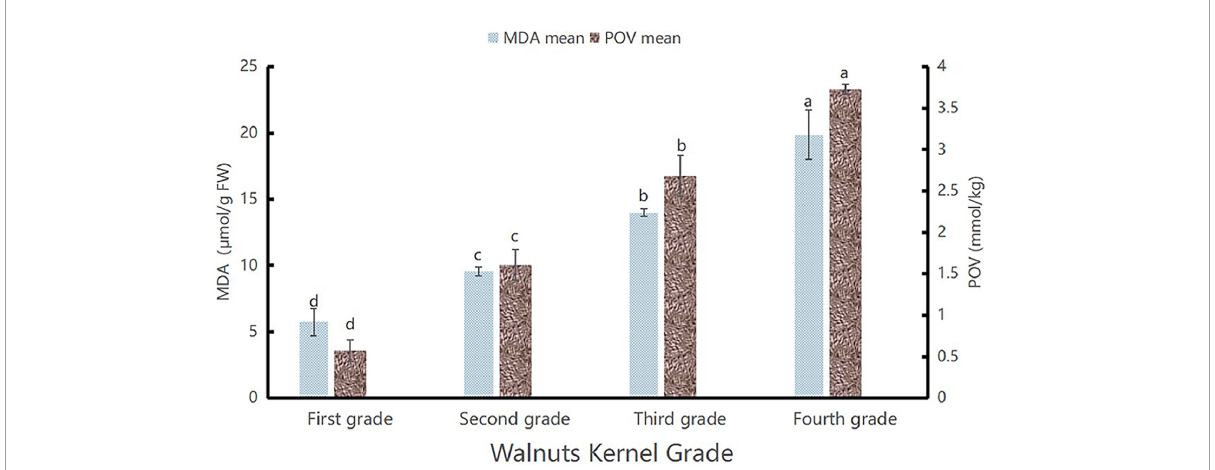
FIGURE1 MDA and peroxidation value (POV) diagram. The highest values of POV and MDA contents are marked as “a”, the second highest as “b”, the third highest as “c”, and the lowest as “d”.